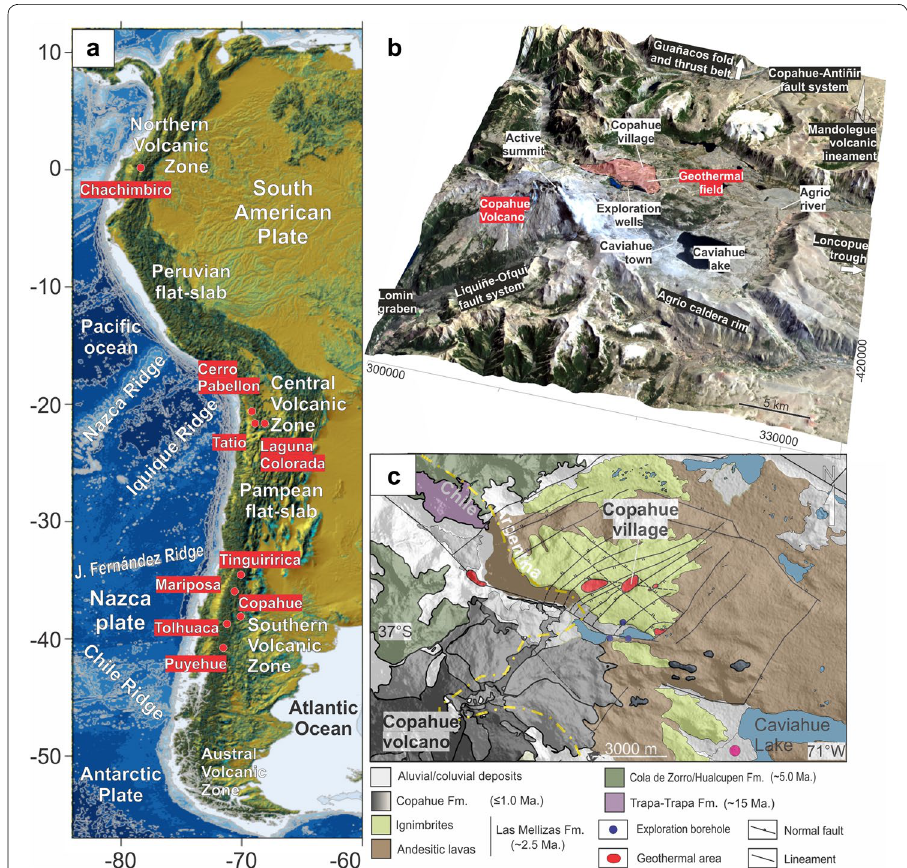
Fig. 1 a Location of the most advanced geothermal projects along the Andes Cordillera. Main tectonic segments and features are also indicated. b 3D view of the Copahue volcano, showing the geothermal field location; 90-m digital elevation model (Shuttle Radar Topography Mission data), combined with Landsat 8 satellite imagery. c Geologic map of the geothermal